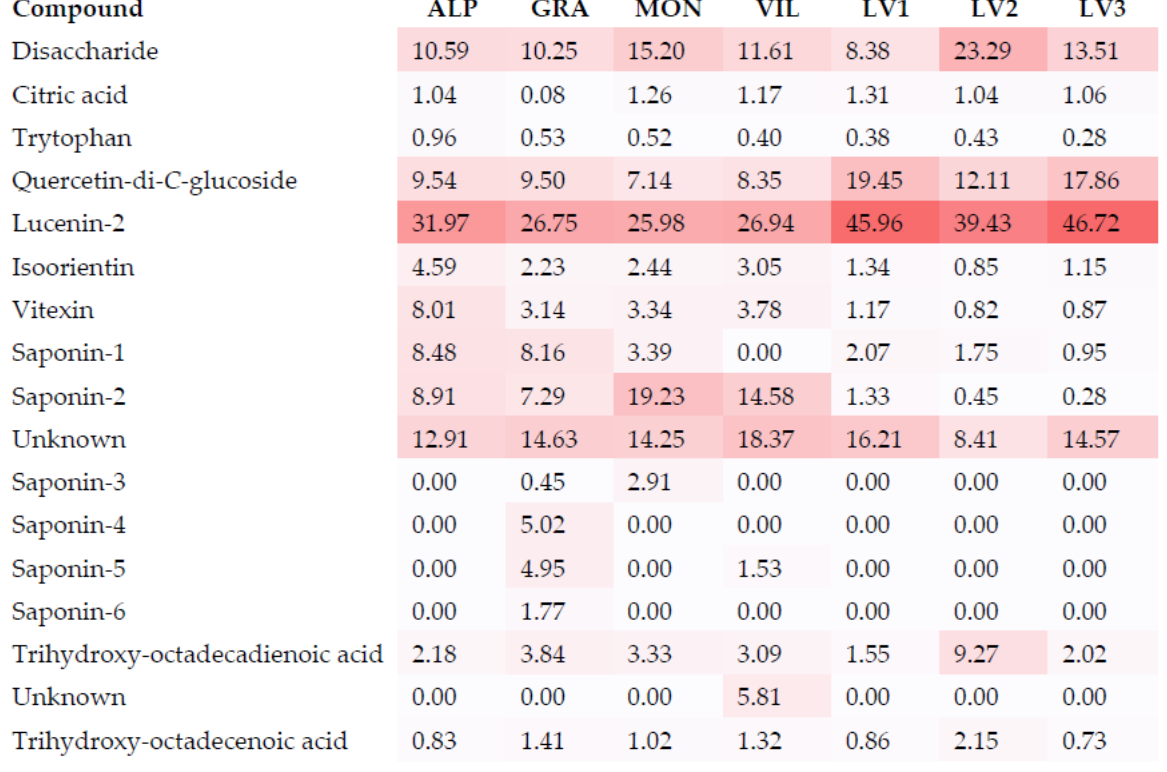
Figure 2. Relative peak areas and heat map obtained by HPLC-Q-TOF-MS analysis of extracts of C. reverchonii .